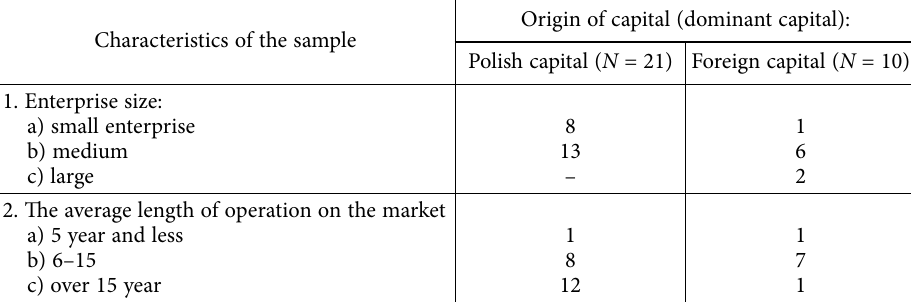
Origin of capital (dominant